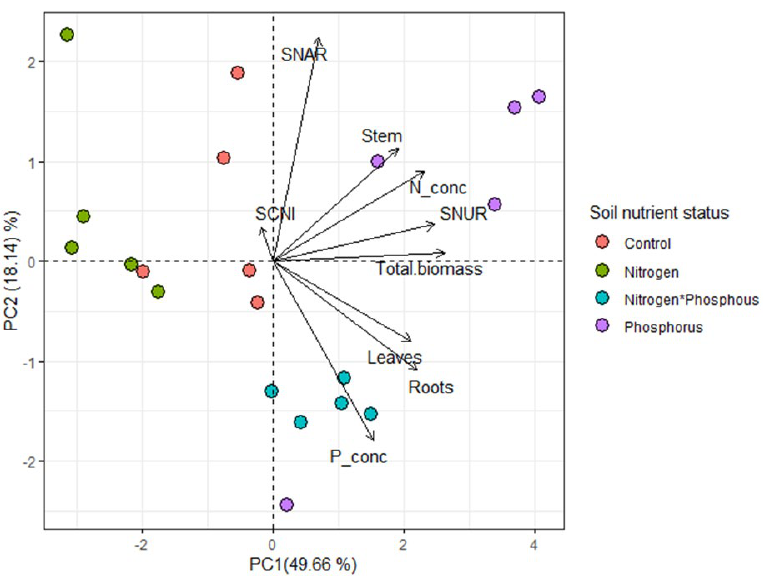
Figure 4. Principal component analysis (PCA) for standardized plant mineral nutrition and growth kinetics trait variables under four different soil nutrient status treatments control (no nutrients), nitrogen (limestone ammonium nitrate), phosphorus only and both nitrogen (limestone ammonium nitrate) and phosphorus. The plot shows the relationship among the plant growth, mineral and ni- trogen-use efficiency variables. Positively correlated variables are grouped together, and negatively correlated variables are positioned on the opposite ends from the plot origin. The quality of the variables is assessed by the distance between the variable and the origin. The longer the length of the variables, the greater its level of contribution. Labels: Leaves—leaves biomass (g); Roots—roots biomass (g); stems—stem biomass (g); Total.biomass—overall plant biomass (g); P_conc—plant phosphorus concentration (µmol P. g −1 ); N_conc—plant nitrogen concentration (mmol Ng −1 ); Table 2. Vachellia sieberiana biomass and mineral nutrition grown in control soils (no nutrients) and soils enriched with nitrogen (limestone ammonium nitrate), phosphorus and both nitrogen (lime- stone ammonium nitrate) and phosphorus obtained from the Ukulinga Grassland Nutrient Experi- ment, South Africa. Different letters indicate significant differences among treatments per parame- ter, at p ≤ 0.05 . Table 1. The chemical parameters of control soil (no nutrients) and soils enriched with nitrogen (limestone ammonium nitrate), phosphorus and both nitrogen (limestone ammonium nitrate) and phosphorus obtained from the Ukulinga Grassland Nutrient Experiment, South Africa.